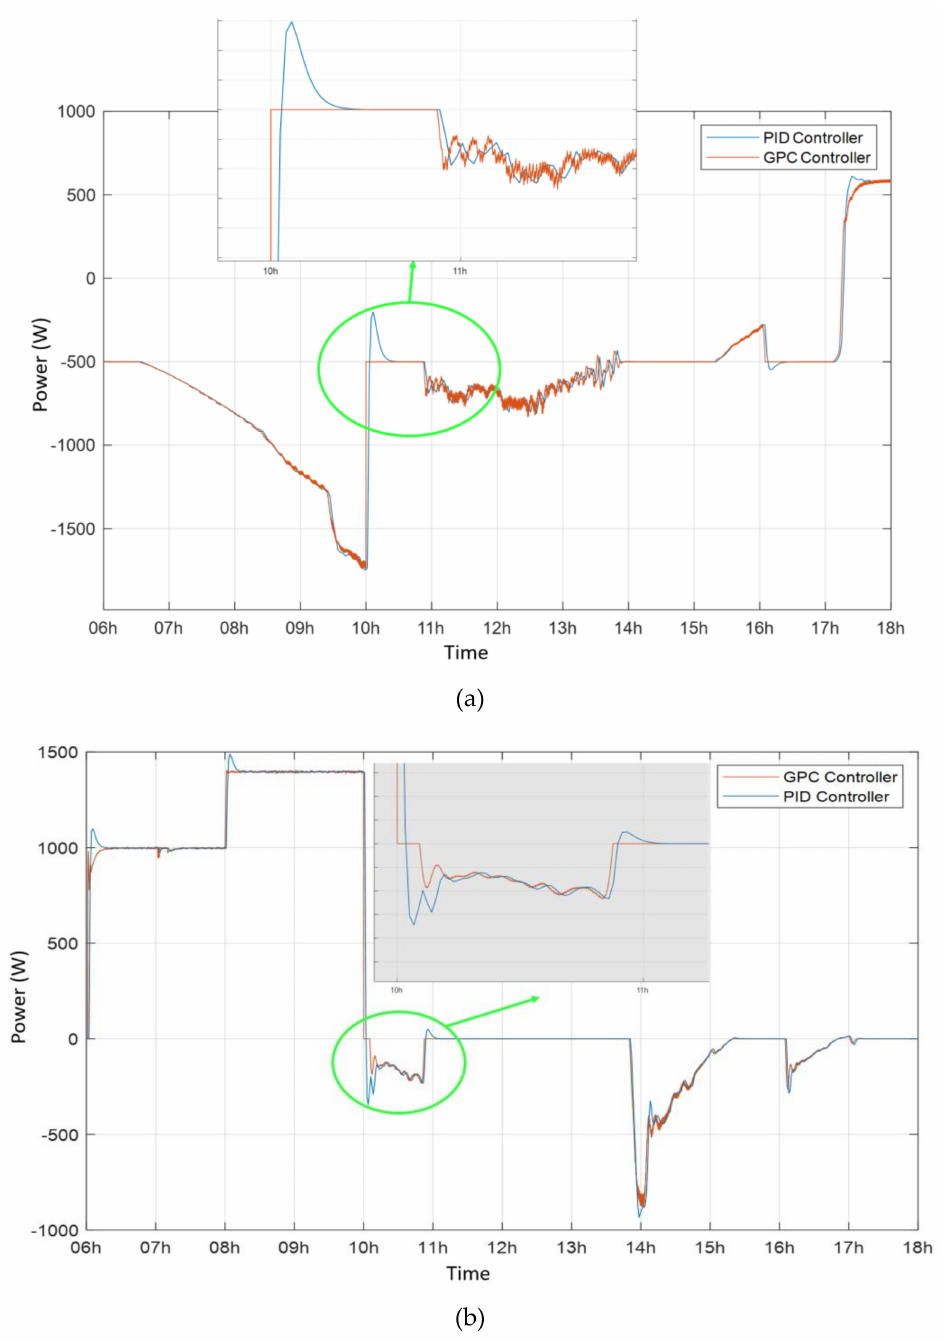
Figure 16. Power regulation for GPC and PID controller, ( a ) battery power regulation, ( b ) grid power